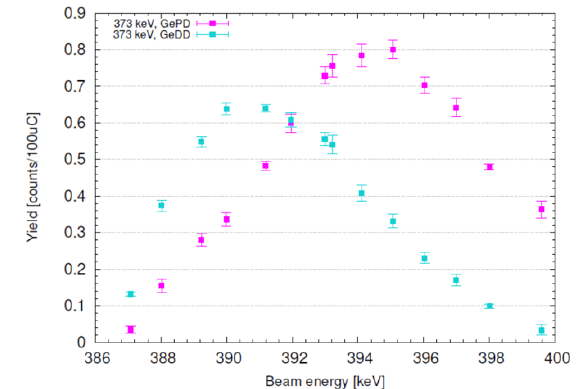
Fig. 4 Gamma yield measured by the two detectors for the DC-> 2425 keV transition (E g =373 keV).